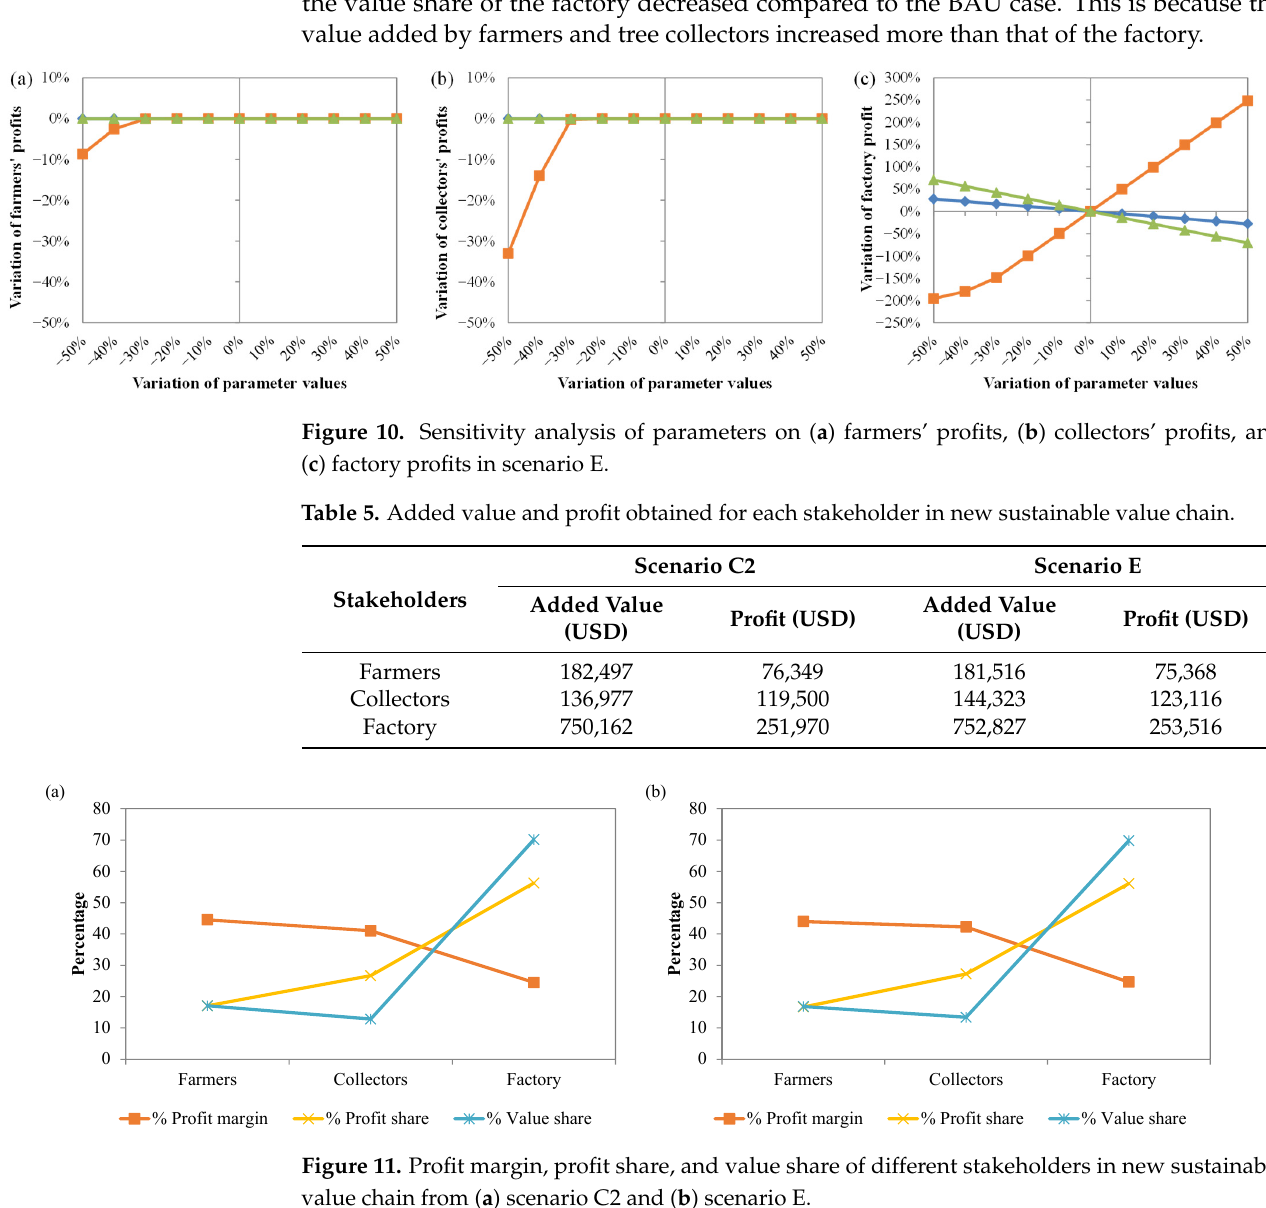
Figure 9. Sensitivity analysis of parameters on ( a ) farmers’ pro fi ts, ( b ) collectors’ pro fi ts, and ( c ) factory pro fi ts in scenario C2.